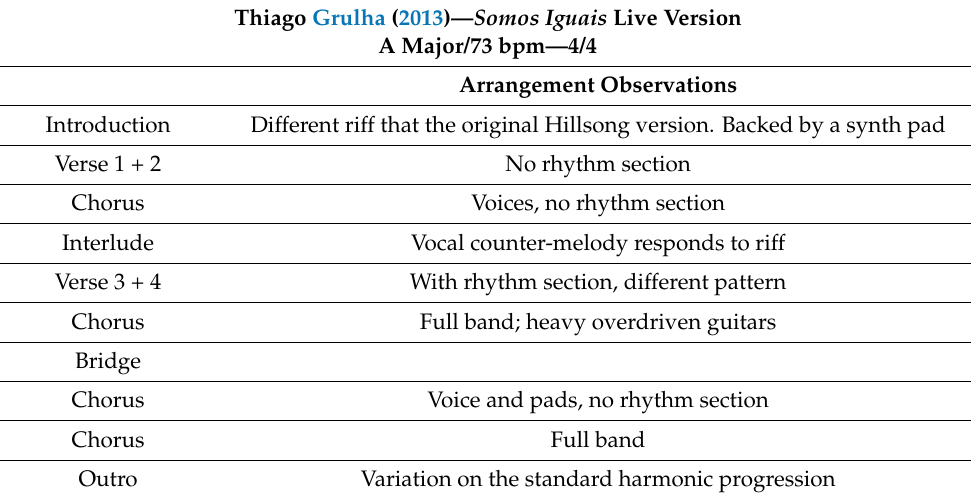
Table 6. Form and arrangement outline of Thiago Grulha’s version of “Poder pra